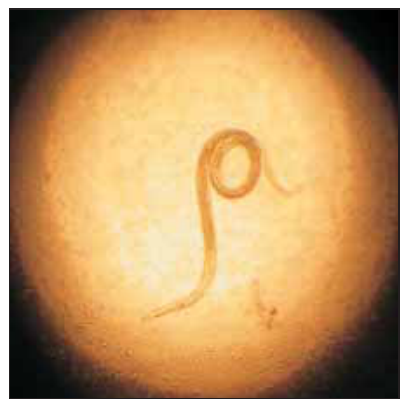
H.contortus Figure-3: Standard PCR from pooled 3 H. contortus, larvae of Lane M : 100 bp DNA ladder, Lane 1 : Rohilkhand strain, Lane 2 : Jhansi strain, Lane 3 : Jaunpur strain, Lane 4 : Varanasi strain